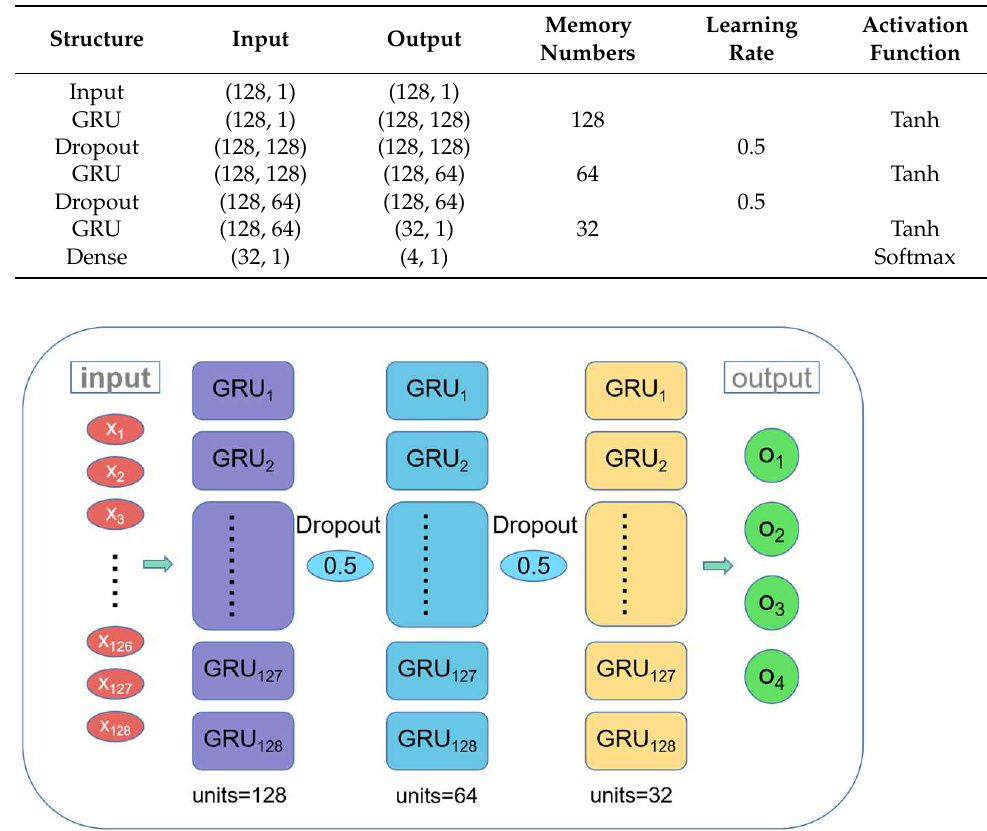
Table 4. Structural parameters of single-fault (cylinder) diagnosis network.